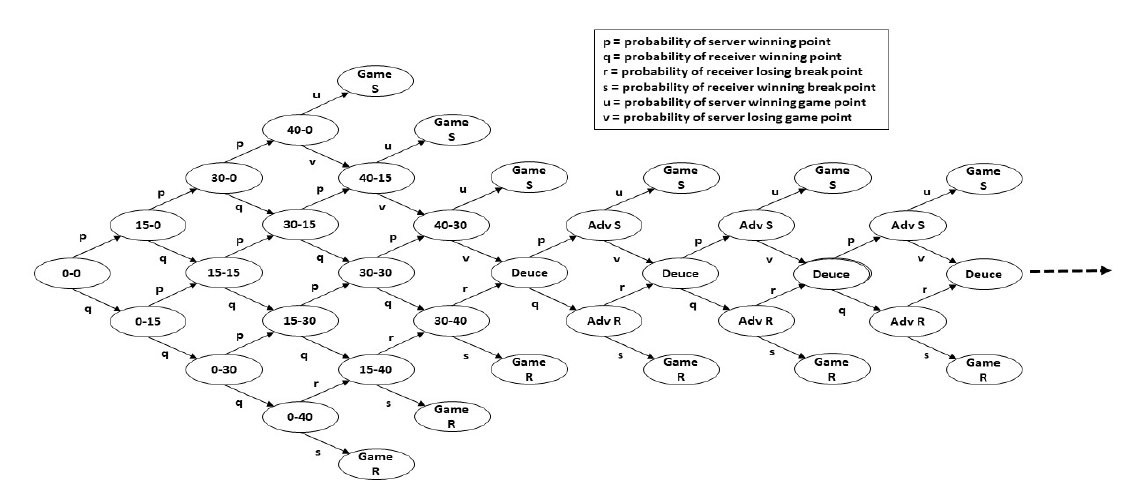
Figure 1. Pathways to winning or losing a traditional tennis game.